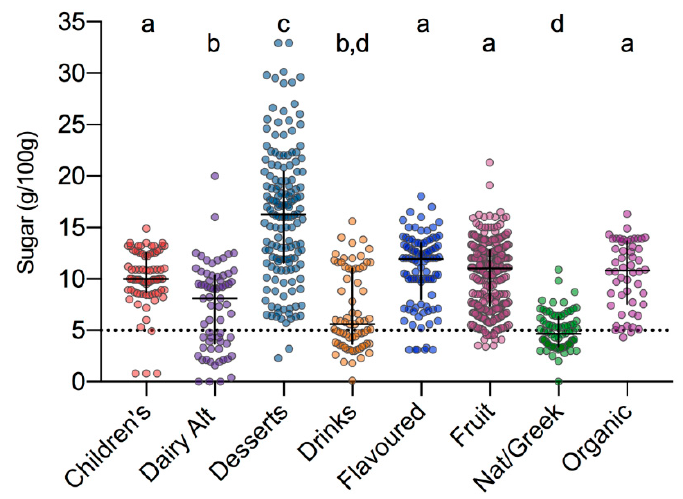
Figure 3. Total sugar content of UK yogurt products across categories. Black cross indicates median and interquartile range. Data were tested for normality and analysed using the Kruskal–Wallis and Dunn’s multiple comparison tests; categories not assigned the same lettering (a–d) are significantly different. Dashed line indicates threshold defined by European Union (EU) regulations for low-sugar nutrition claim [17] .